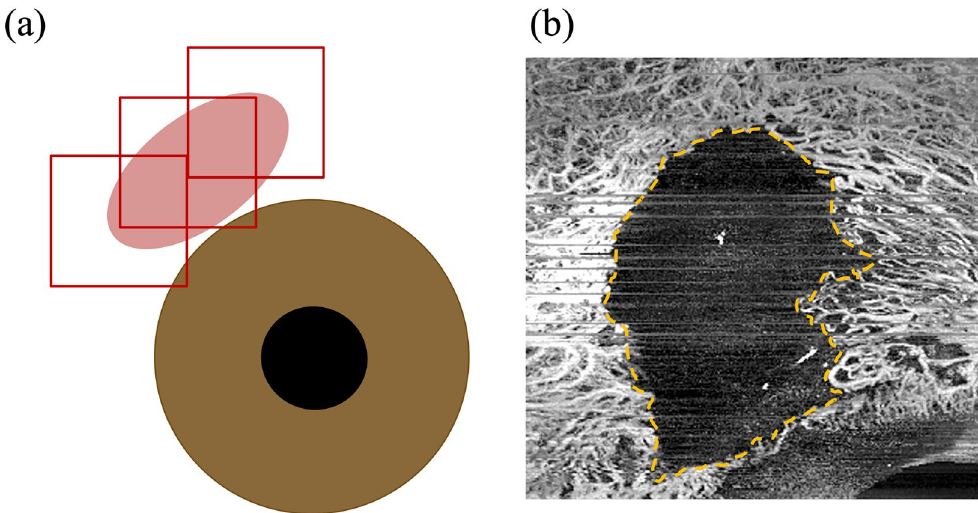
Figure 1. Anterior segment optical coherence tomography angiography assessment of complete avascular area (CAA) in the filtering bleb. ( a ) 3 × 3 mm AS-OCTA images are taken at the center of the filtering bleb, with the scleral flap and its nasal and temporal sides scanned in the same manner. ( b ) The extent of CAA (%) is calculated by dividing CAA in pixels by the total number of pixels (1,048,576 = 1024 × 1024